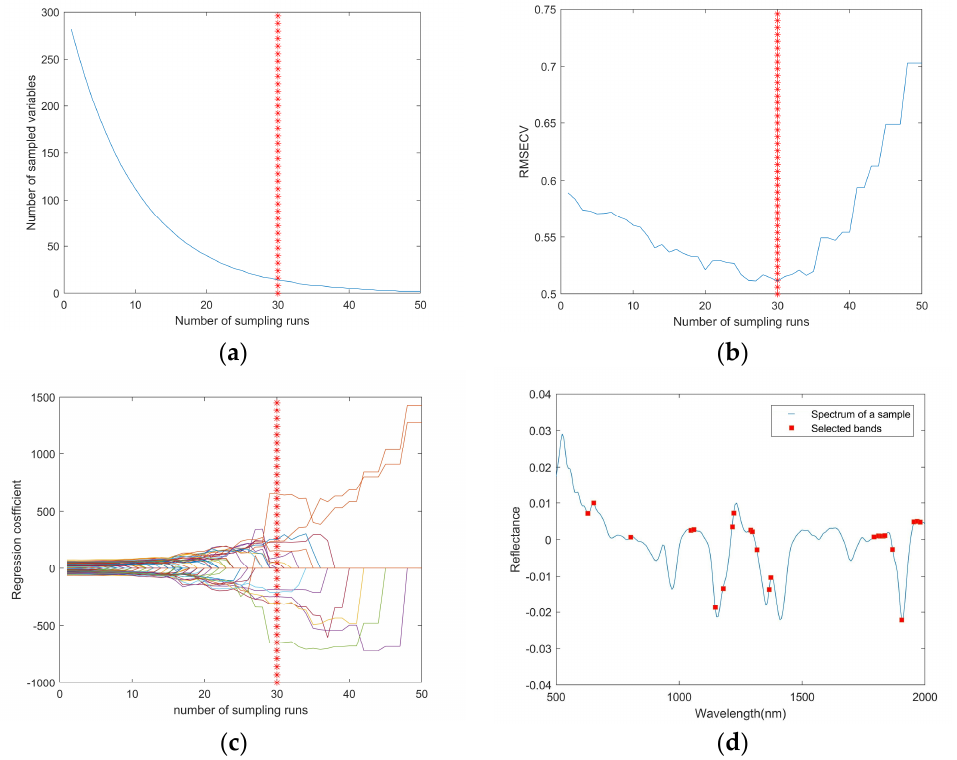
Figure 4. Results of the CARS algorithm for screening effective variables from full wavelengths. Changing trend of the number of sampled wavelengths ( a ), RMSECV values ( b ) and regression coefficients of each wavelength ( c ) with the increasing of sampling runs. The asterisk line denotes the optimal point where RMSECV values achieve the lowest. ( d ) Variables selected by CARS algorithm.